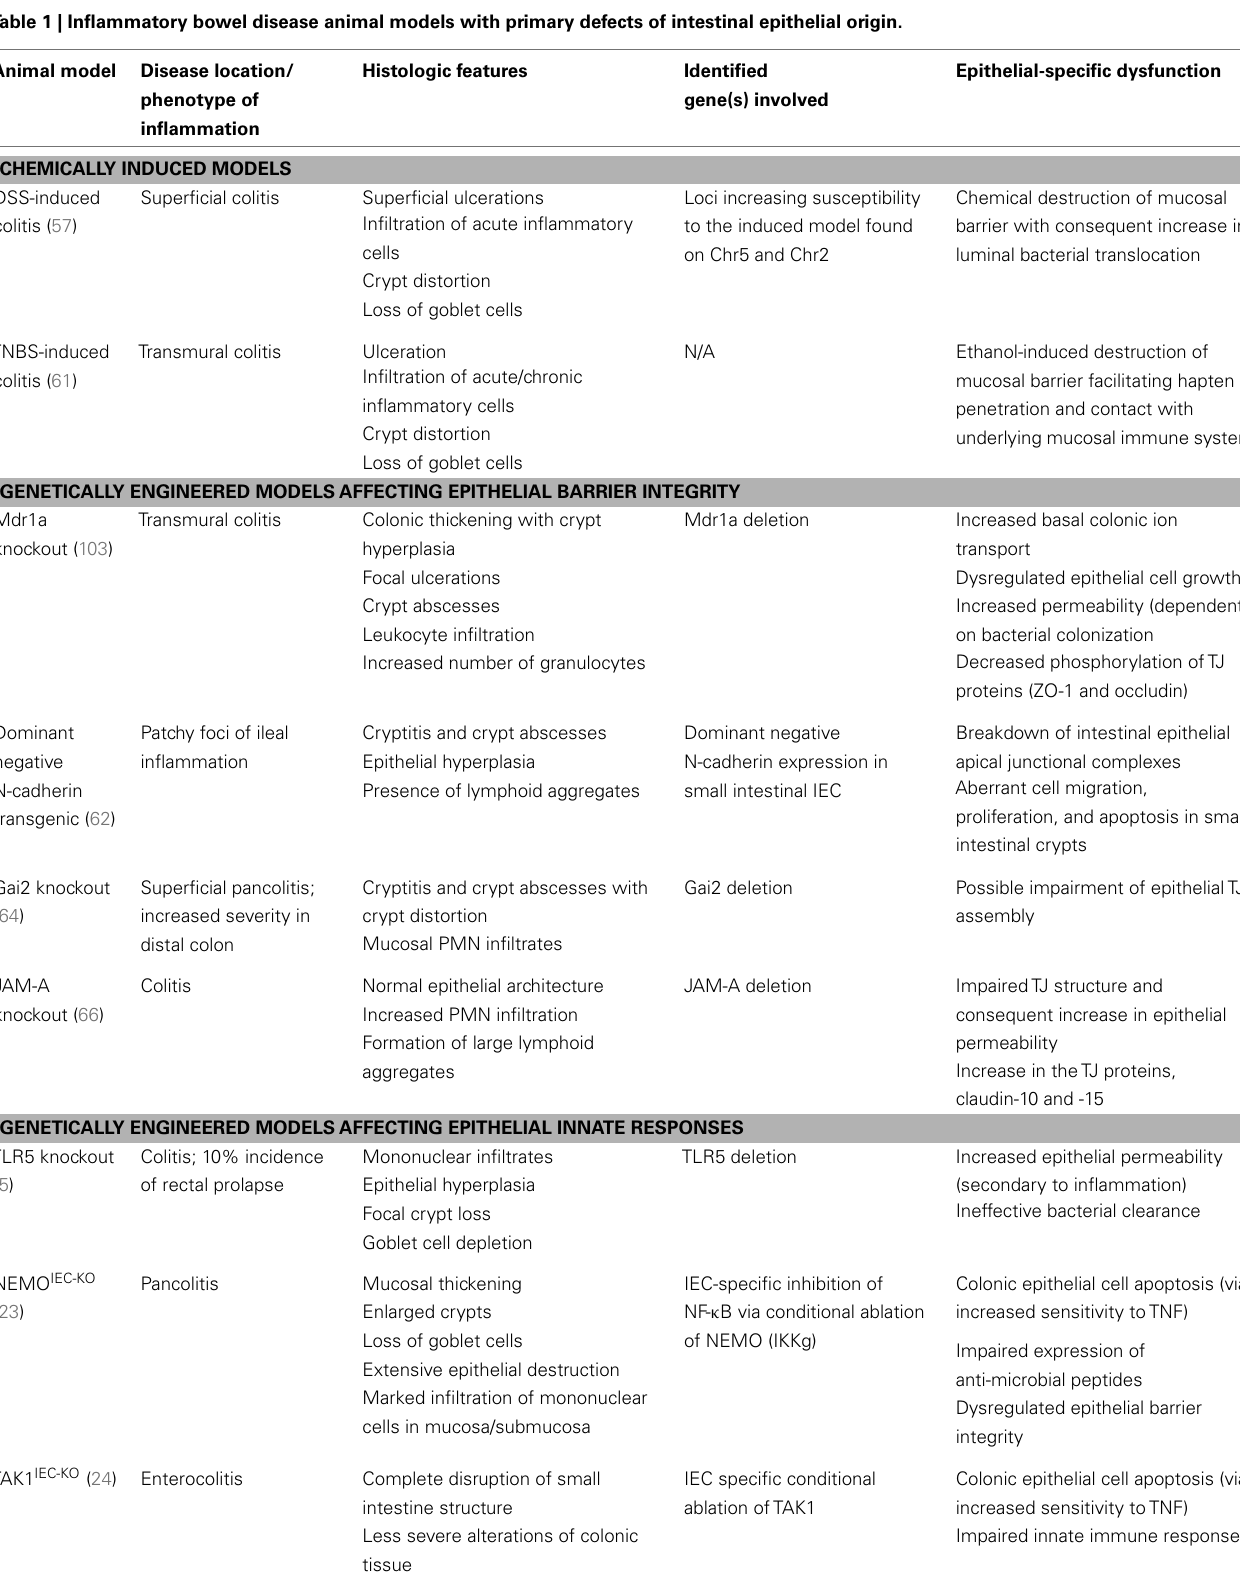
Table 1 | Inflammatory bowel disease animal models with primary defects of intestinal epithelial origin. Animal model Disease